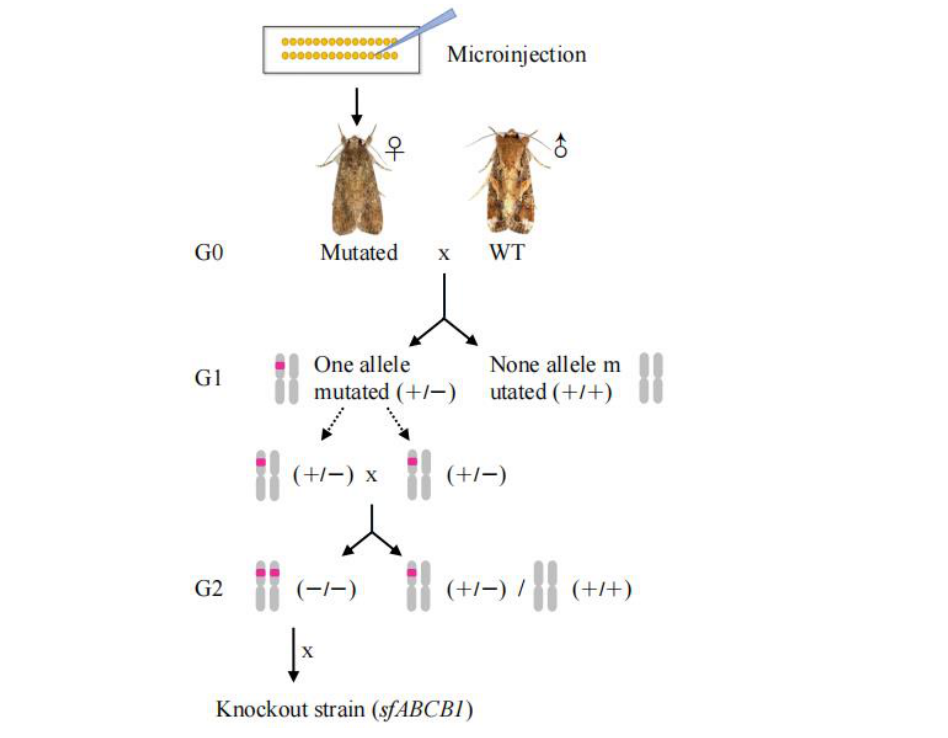
Figure 2. Diagram detailing crossing strategy to obtain a homozygous strain. The G0 moths were heterozygous mutant after microinjectionDH19. Moths from DH19 and mutant G0 moth were mated to obtain G1 generation. Heterozygous G1 individuals were mass-crossed to obtain G2 generation, and 14.6% (14/96) of the tested individuals were identified as homozygous. These homozygous individuals were pooled to produce a SfABCB1 knockout strain (ABCB1-KO). Table 1. Susceptibility of third instar larvae from ABCB1 knockout strain ( SfABCB1 ) and wild-type strain of Spodoptera frugiperda to 10 different